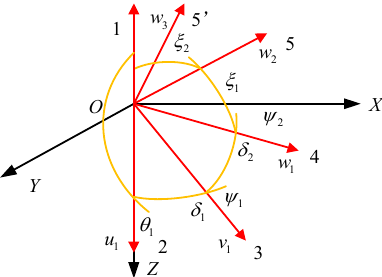
Figure 5. Motion chain of the spherical polygon.